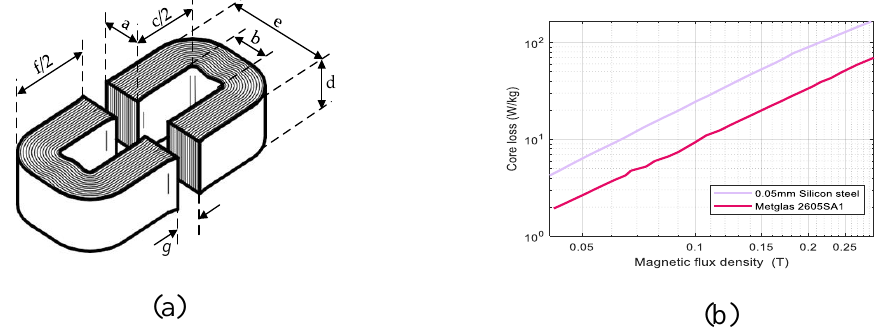
Figure 23. ( a ) Geometry parameters of the AMCC50 core and ( b ) Core loss curve of conventional steel Figure 23 . (a) Geometry parameters of the AMCC50 core and (b) Core loss curve of conventional steel and Metglas 2605SA1 at 20kHz current [178]. and Metglas 2605SA1 at 20kHz current [178]. Table 4 . DC-DC converter parameters for performance testing.